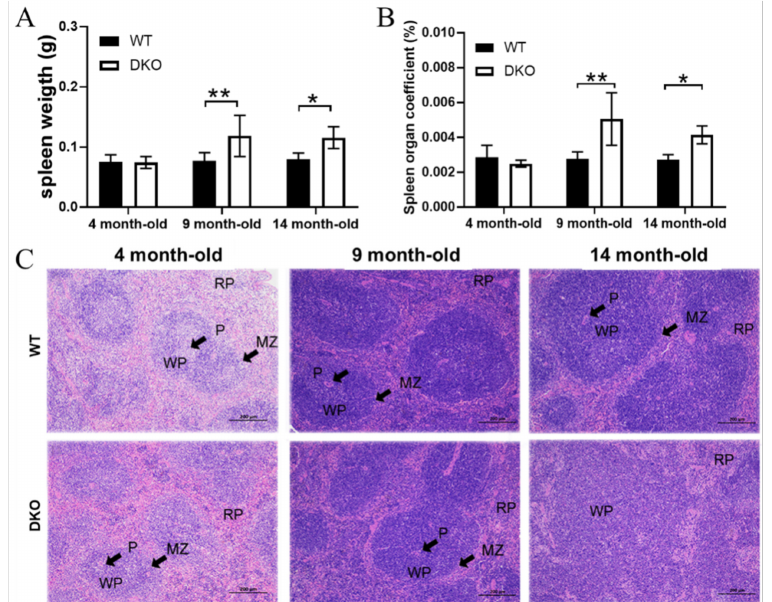
Figure 1. Physiological effect indices and HE staining of spleen from DKO and WT mice of different ages. ( A ) Spleen weight (g). ( B ) Spleen organ coefficient (%). ( C ) Spleen HE staining. White pulp (WP), red pulp (RP), periarterial lymphatic sheath (P), and marginal area (MZ), scale = 200 µ m. Data are presented as mean ± SD, n = 20. * p < 0.05, ** p <